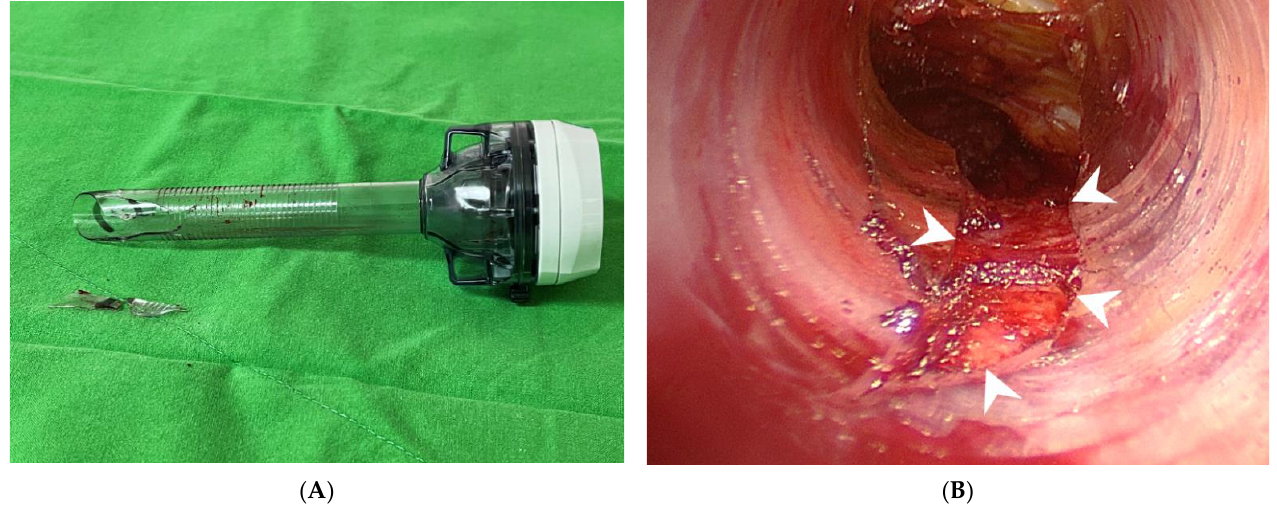
Figure 2. The broken cannula in Case 2. ( A ) The fracture is in the distal end of the cannula. Two fragments were retrieved. ( B ) Intraoperative view shows a cannula fracture with a defect on the ventral side of the cannula ( arrowheads ).